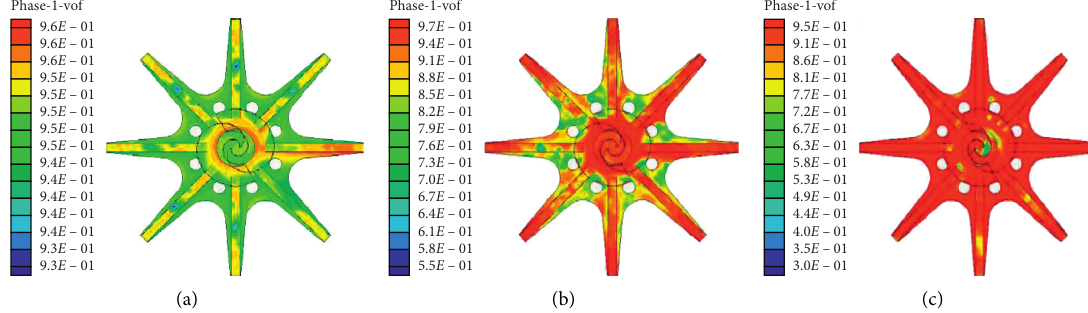
Figure 10: Concentration distribution of the liquid phase of different particle size. (a) D � 0 . 01. (b) D � 0 . 1. (c) D � 0 . 2.